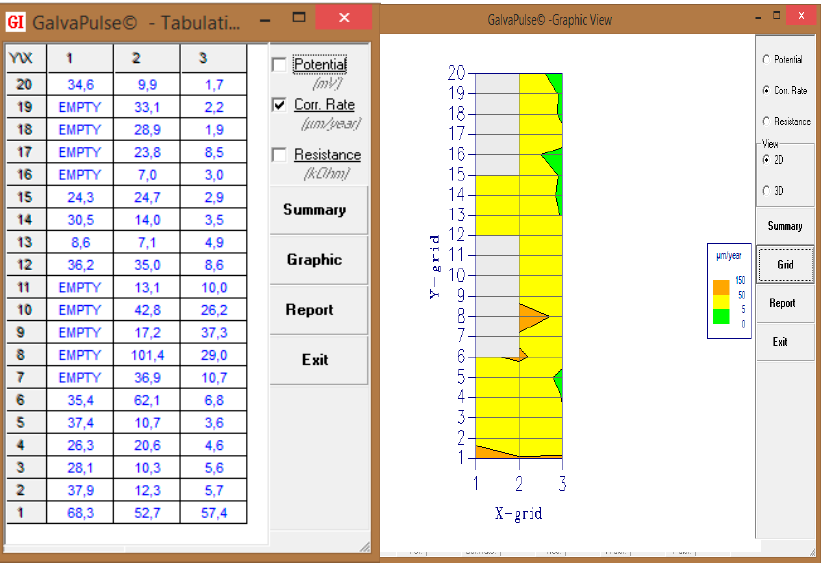
Figure 6. The results of the corrosion measurements current density converted to the rate of corrosion.